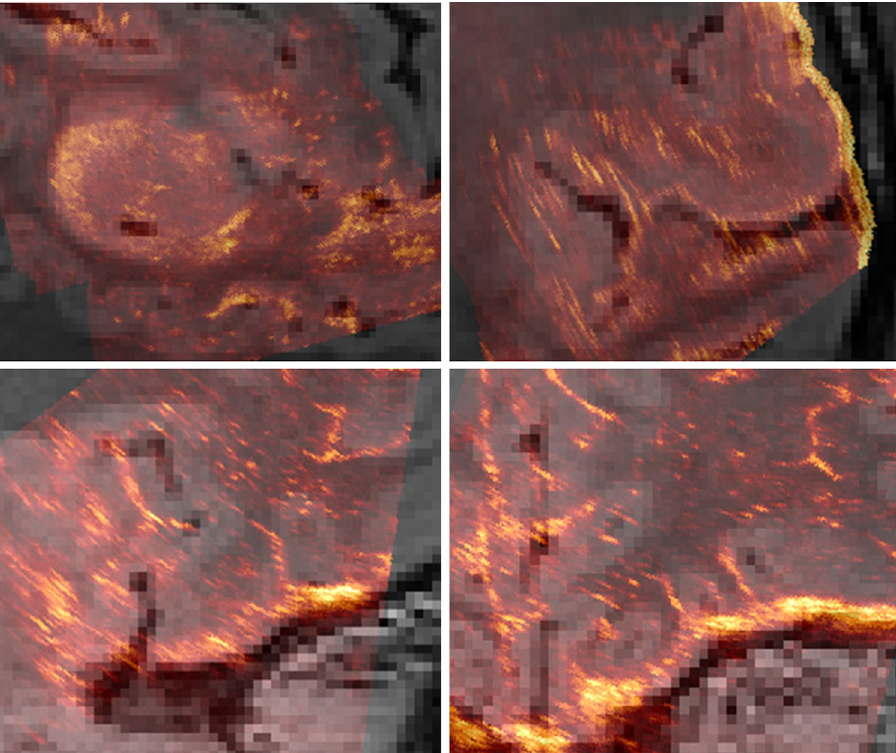
Figure 4. Two examples of MR Images (grey scale) combined with registered iUS volume overlays (yellow-red image) using the proposed method. Each row represent a dataset. Left: sagittal view, right: coronal view.